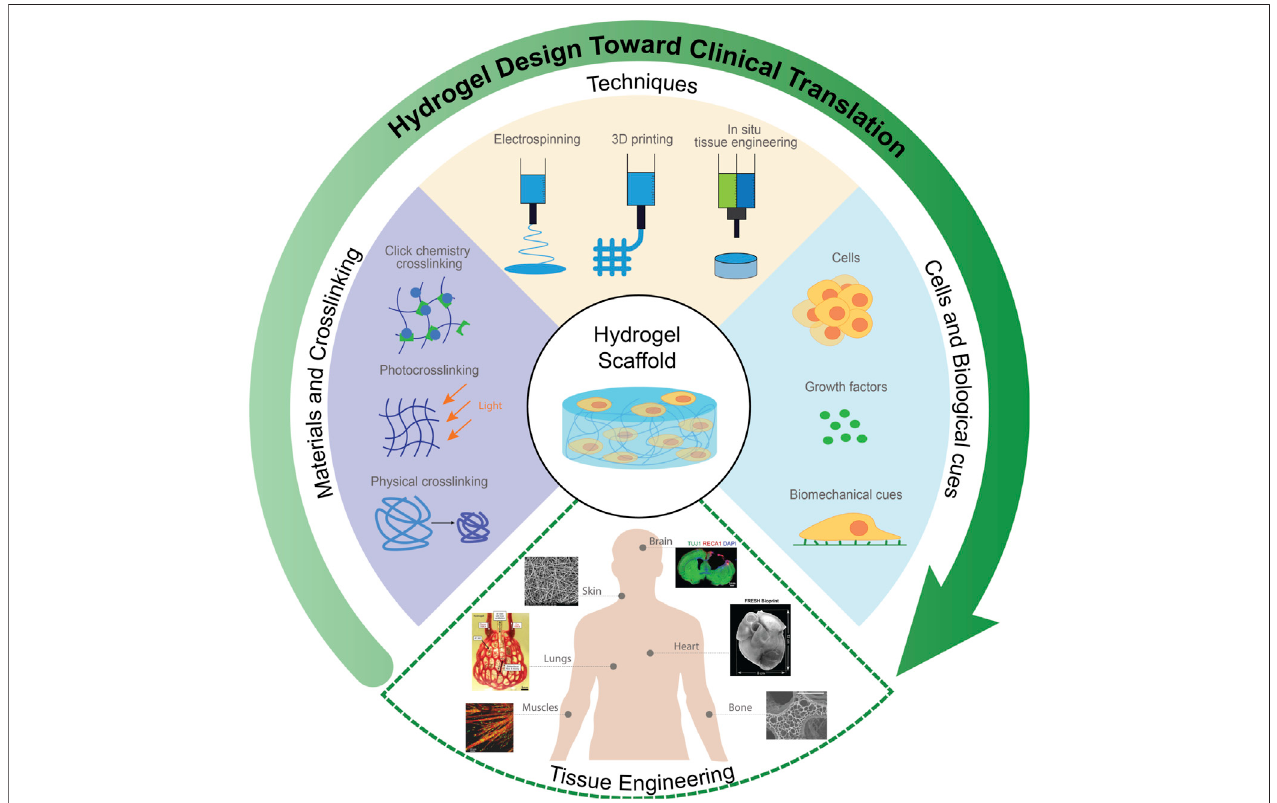
FIGURE1| Designoffunctionalhydrogelsfortissueengineering.Selectedconstituentimagesreproducedwithpermissionfromreferences(Jinetal.,2011;Fuoco et al., 2014; Fang et al., 2016; Grigoryan et al., 2019; Mirdamadi et al., 2020; Li et al., 2021).